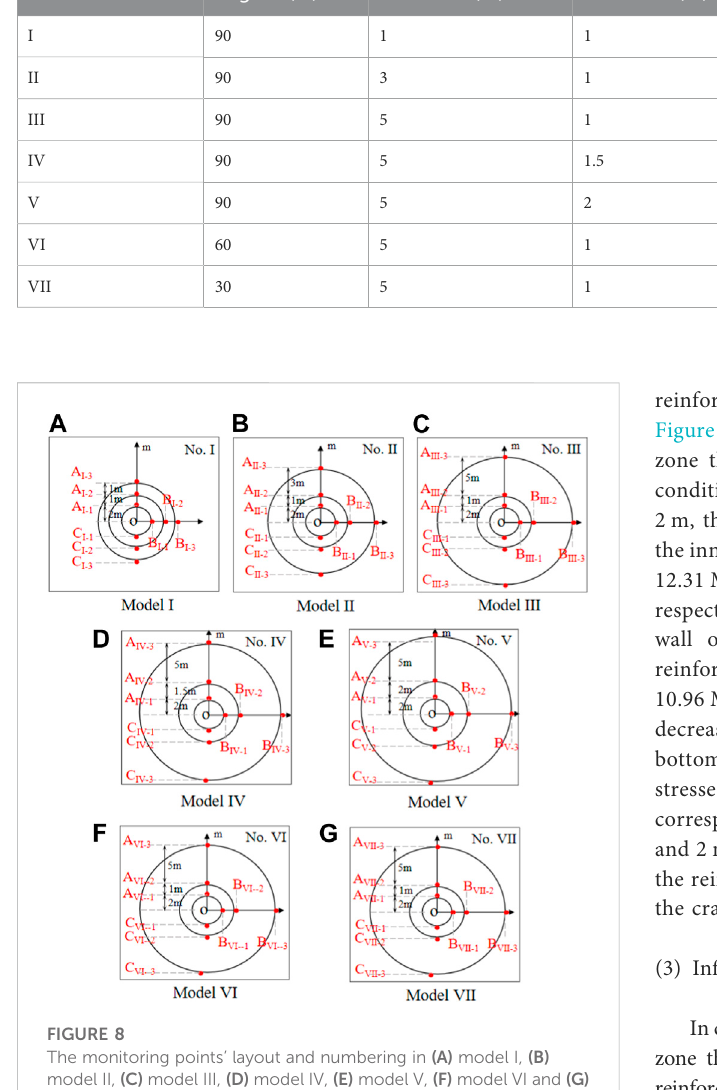
TABLE 3 The detailed parameters of the numerical models. Numerical model no.